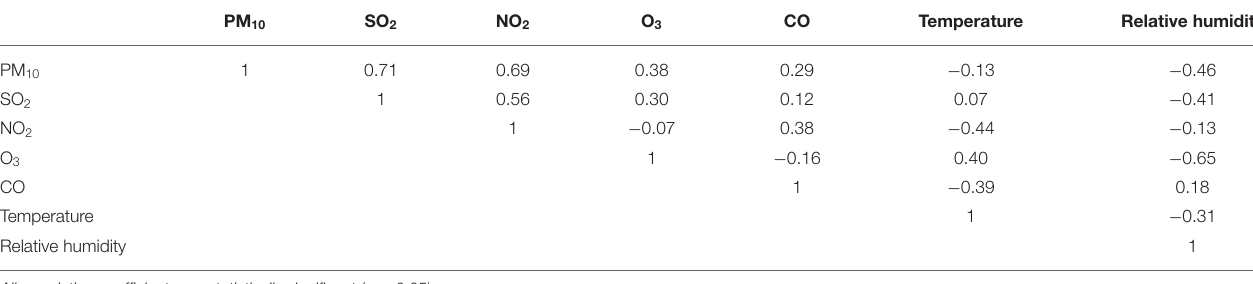
TABLE 2 | Spearman’s correlation of air pollutants and weather conditions.